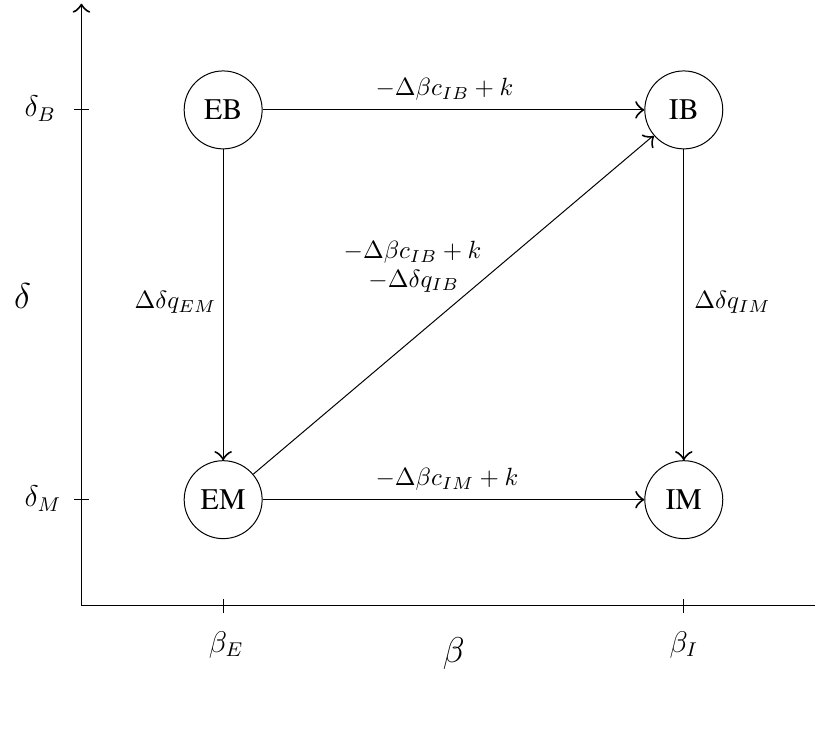
Figure 4. Incentive constraints that are binding in Case